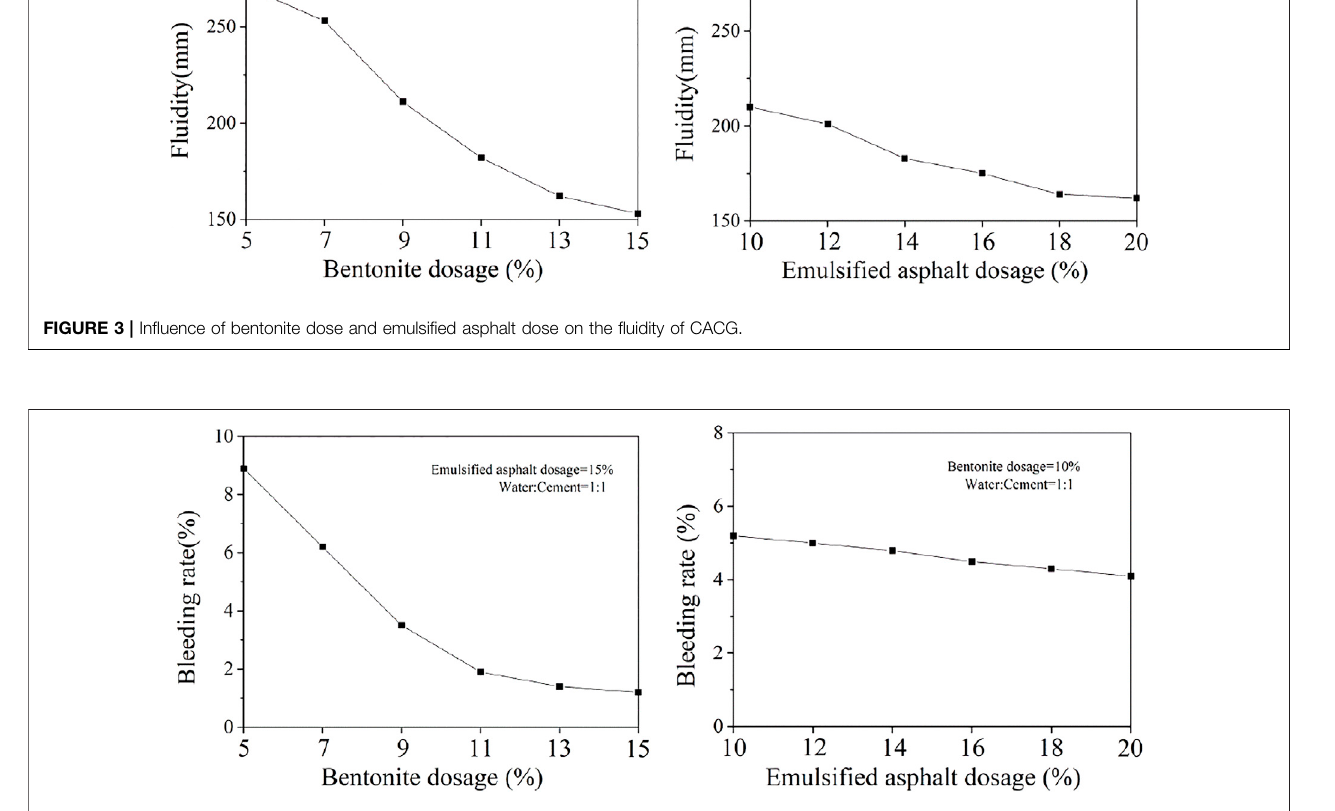
FIGURE 4 | In fl uence of the bentonite dose and emulsi fi ed asphalt dose on the bleeding rate of CACG.